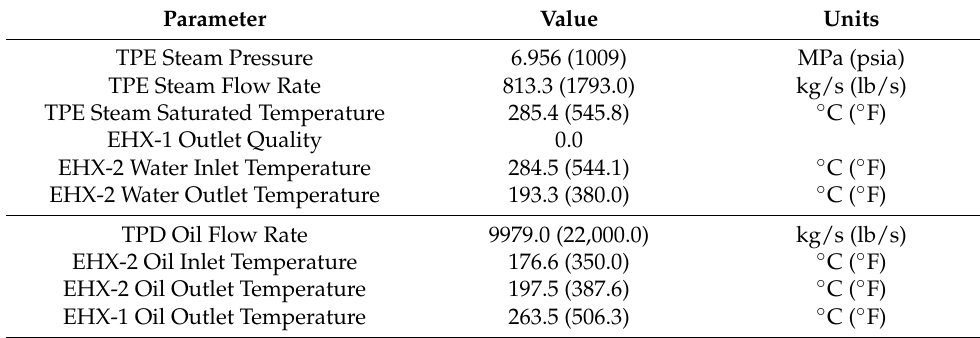
Table 1. Design operating parameters for the TPE and TPD system heat